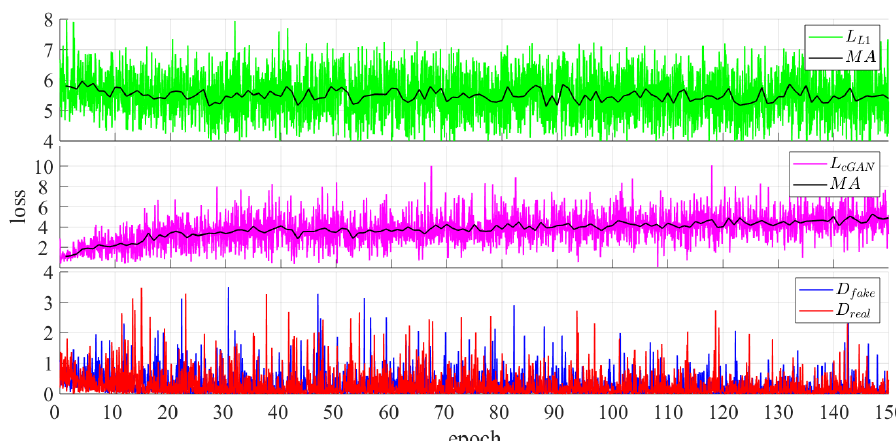
Figure 8. The loss of Dataset 2 over time. MA means the moving average curves with the cycle of one epoch. D real indicates the curve of D ( x , y ) , and D fake represents the curve of D ( G ( z , y ) , y ) .